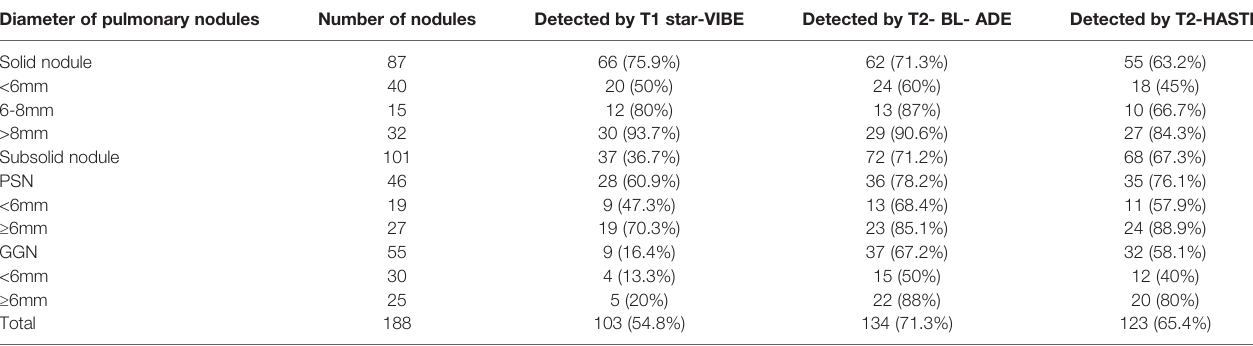
TABLE 3 | The sensitivity of the detection of different subgroups of pulmonary nodules. Diameter of pulmonary nodules Number of nodules Detected by T1 star-VIBE Detected by T2- BL- ADE Solid nodule